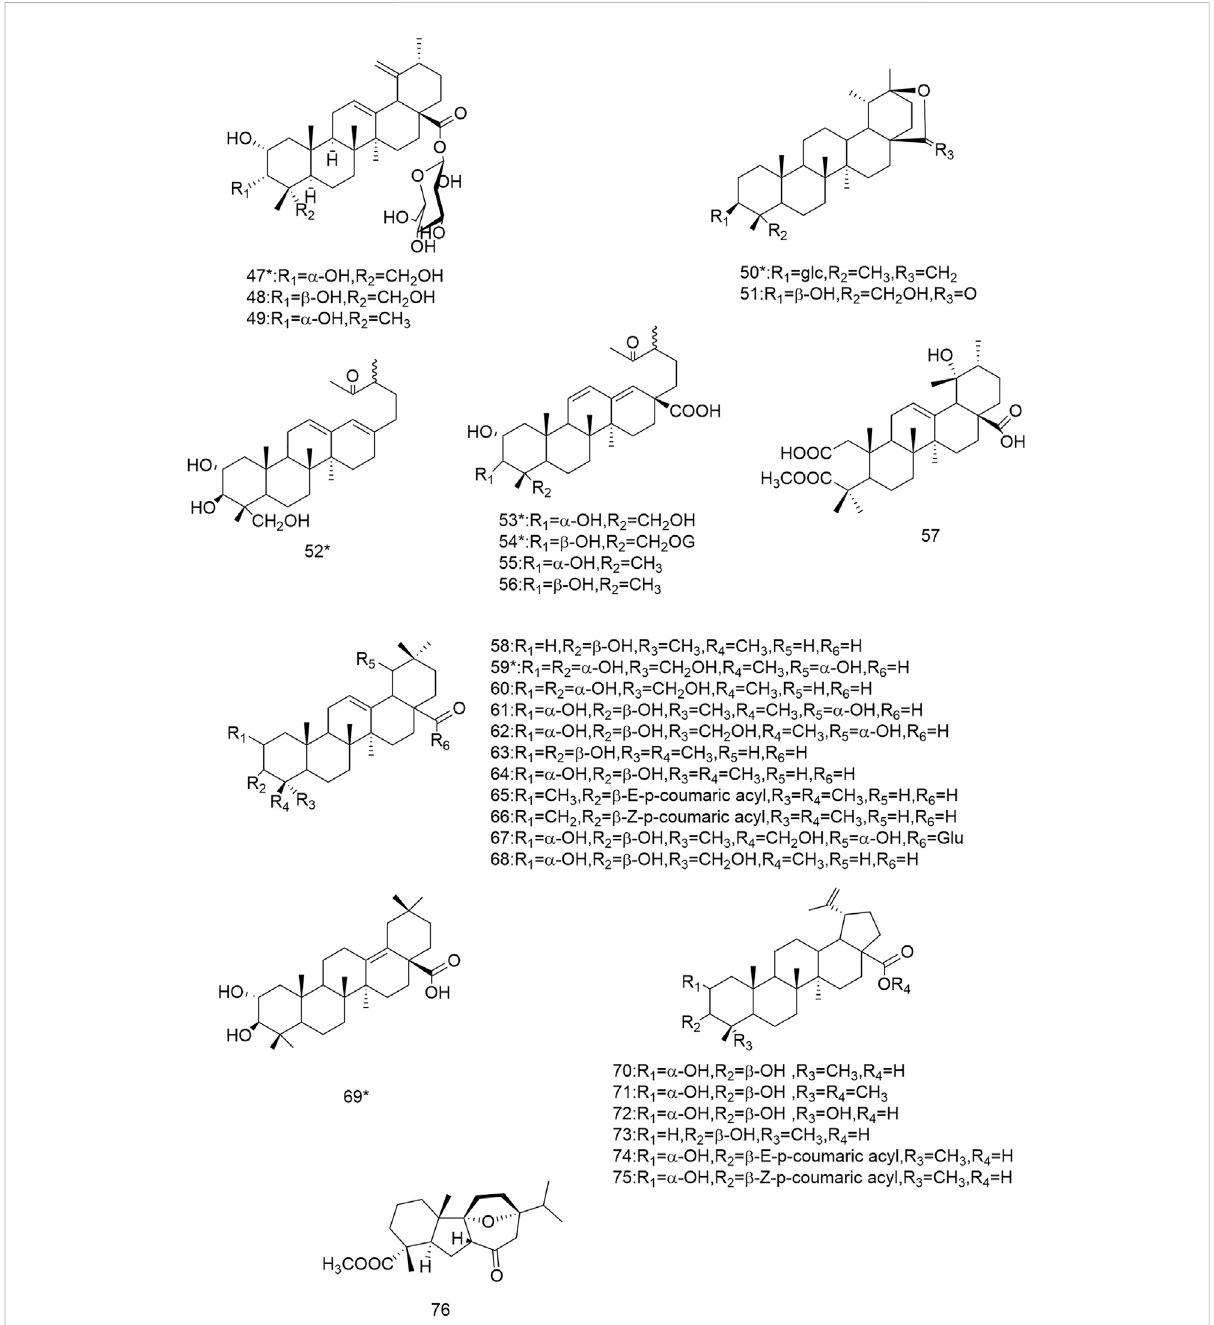
FIGURE 2 Diagrammatic representation of the structural formulas of triterpenoids of compounds found in R. laevigata